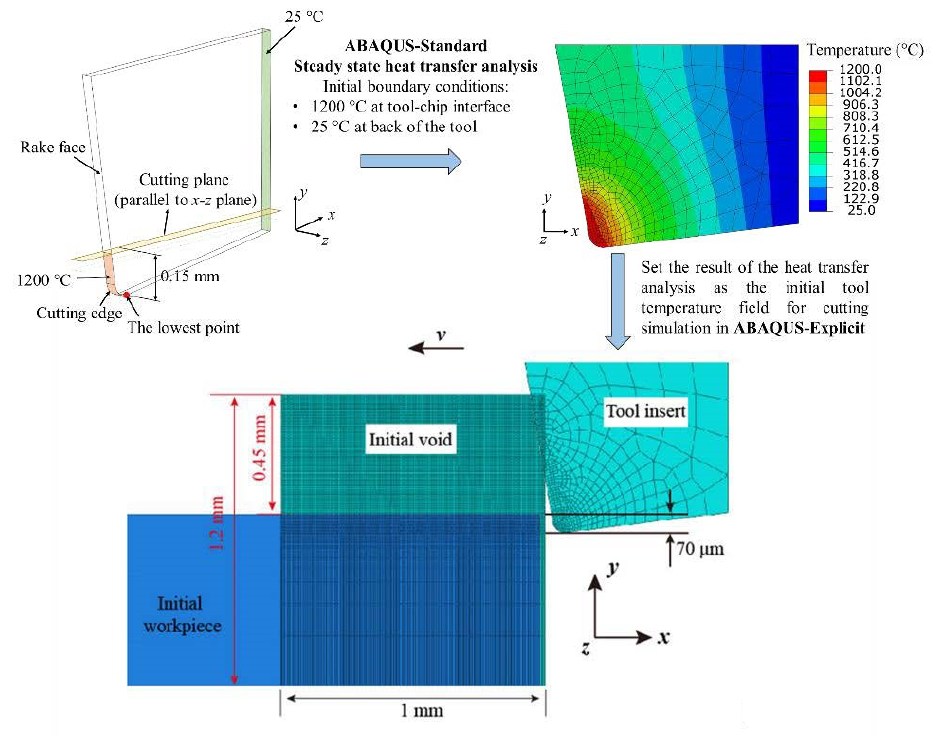
Figure 4. Flow chart of the simulation approach, and the initial geometry and boundary conditions for the heat transfer and cutting simulation with a rake angle of −10°.